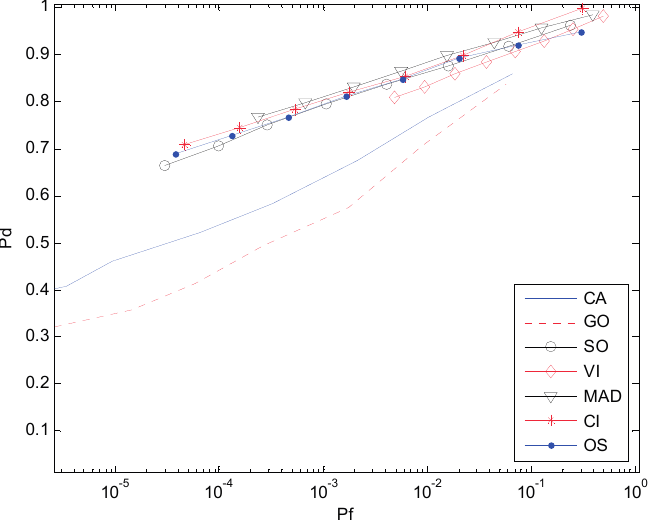
Figure 6. P vs . P (ROC) in the non-homogenous environment with one interference, d f